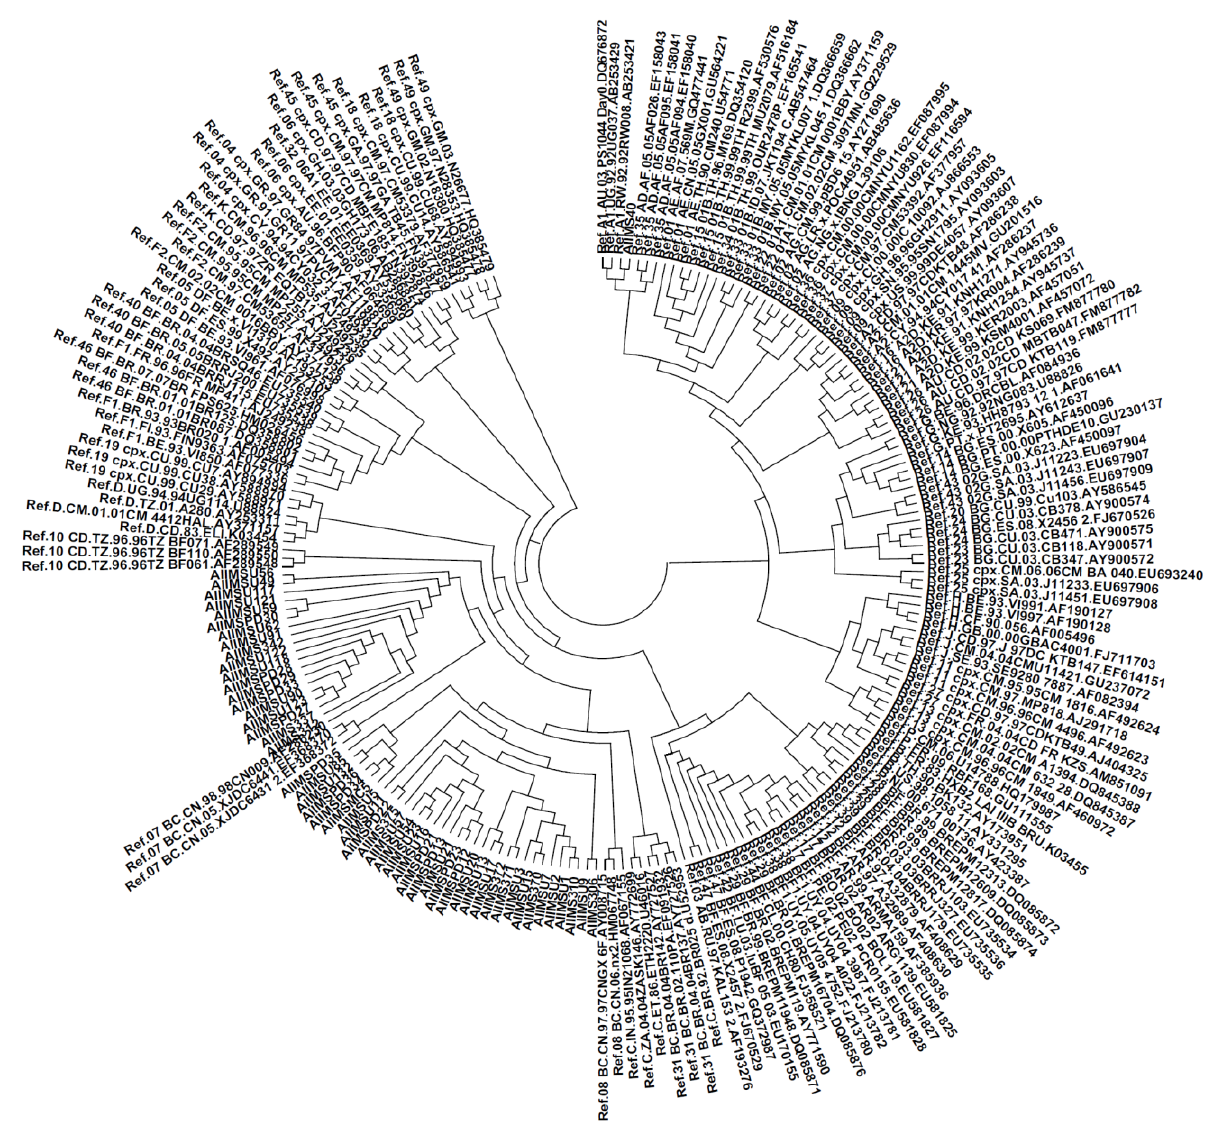
Figure 3. Neighbor-joining phylogenetic tree of Protease sequences obtained from HIV-1 infected Indian children. A phylogenetic tree was constructed using MEGA4.0 software using the neighbor joining method with 1000 bootstrap replicates. The sequences obtained from studied patients are labeled as AIIMS. 33 out of 53 PR sequences aligned with clade C while 19 aligned with subtype B sequences. PR sequences of AIIMS40 aligned with subtype A viral